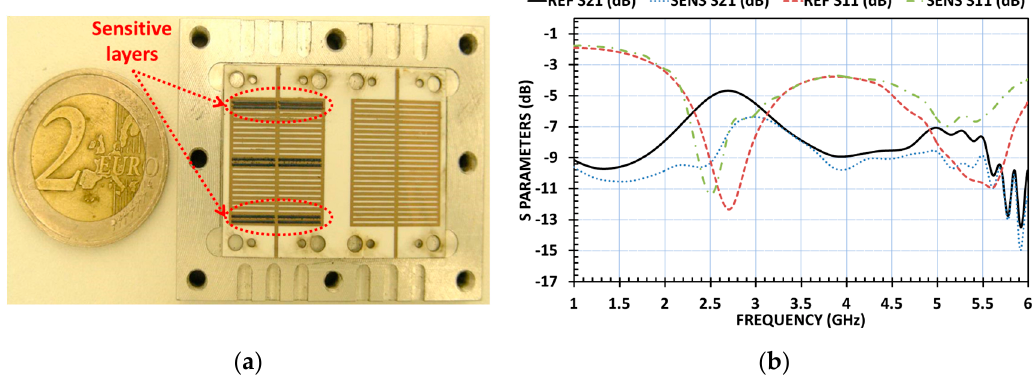
Figure 3. ( a ) Experimental device on paper mounted on the test cell basement; ( b ) Experimental S